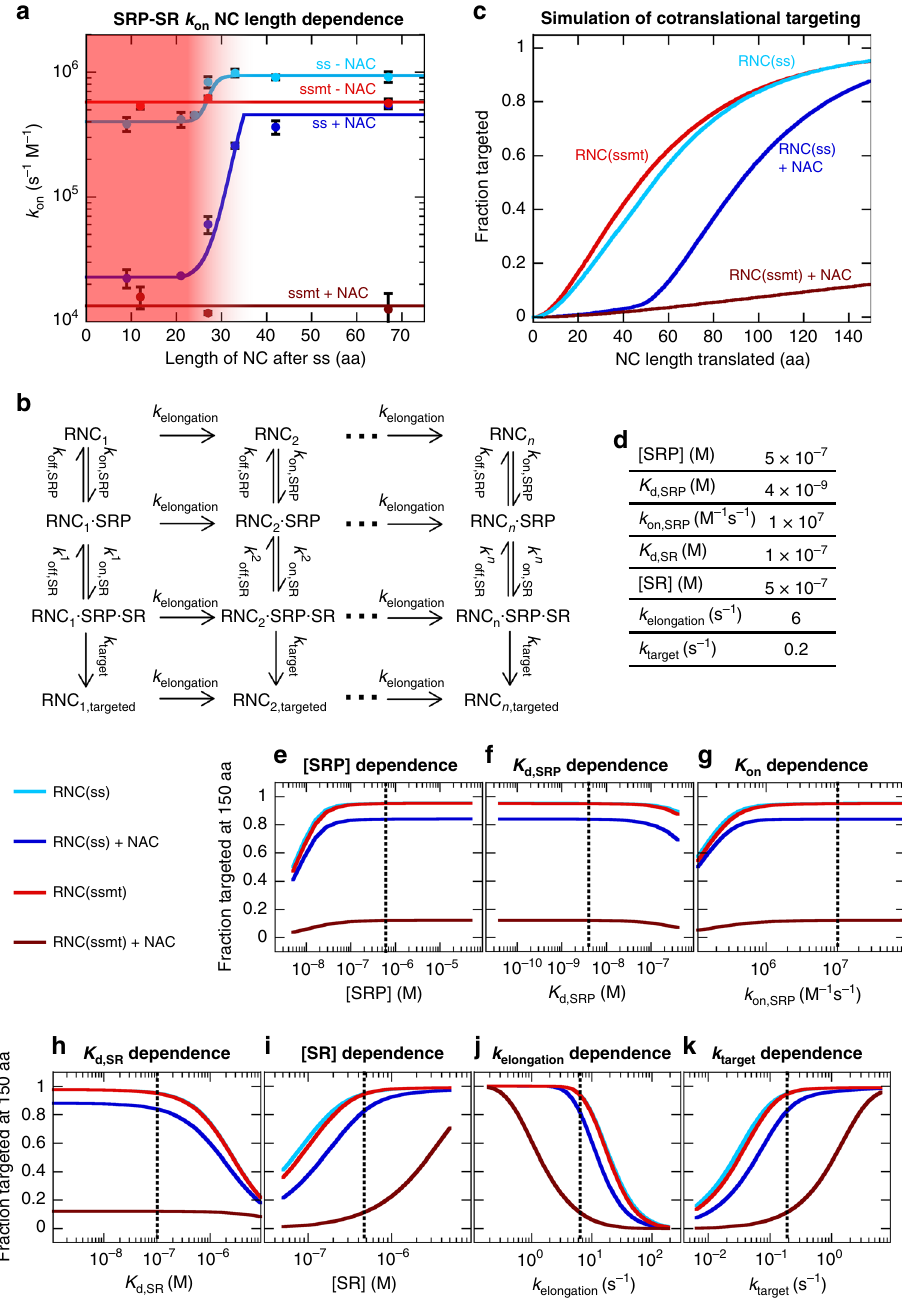
Fig. 7 A computational model for the SRP pathway emphasizes the role of NAC in maintaining targeting speci fi city. a NC length dependence of SRP-SR association rate constants. All measurements used the same concentrations of RNC, SRP and NAC as in Fig. 2g. The red shaded area indicates NC lengths at which the signal sequence is partially or completely buried, assuming that the ribosome exit tunnel accommodates ~35 amino acids. The data were fi t to Eq. (18) in the Methods section (solid lines) for RNC(ss) and to a constant k on value for RNC(ssmt). All experimental data are shown as mean ± SD, with n = 3 – 5 independent measurements on the same biological sample. b Computational model for co-translational protein targeting by SRP and SR. c , d Modeled progression curves for SRP-dependent protein targeting during ongoing protein synthesis with and without NAC present ( c ). The model in b was calculated as described in the Methods section, assuming that the signal sequence is located within the N-terminal 14 amino acids of the nascent protein and that the exit tunnel accommodates 35 amino acids. Values of k on,SR were from ( a ) (solid lines). The other parameters used for the modeling are summarized in d and detailed in the Methods section. e – k Sensitivity of the modeled targeting ef fi ciency to perturbations of the individual parameters in the model. The fraction of successfully targeted RNCs at a nascent chain length of 150 aa was determined as in c , except that each of the parameters listed in d was varied by 1 – 2 orders of magnitude from the estimated values (dotted lines). Source data for a , c , and e – k are provided in the Source Data fi